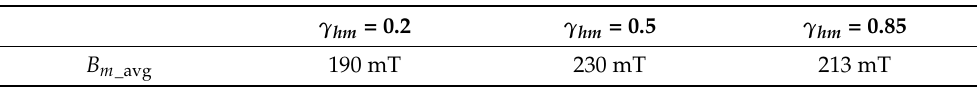
Table 2. Comparison of average vales of magnitude of magnetic induction for different cases of fill factor.